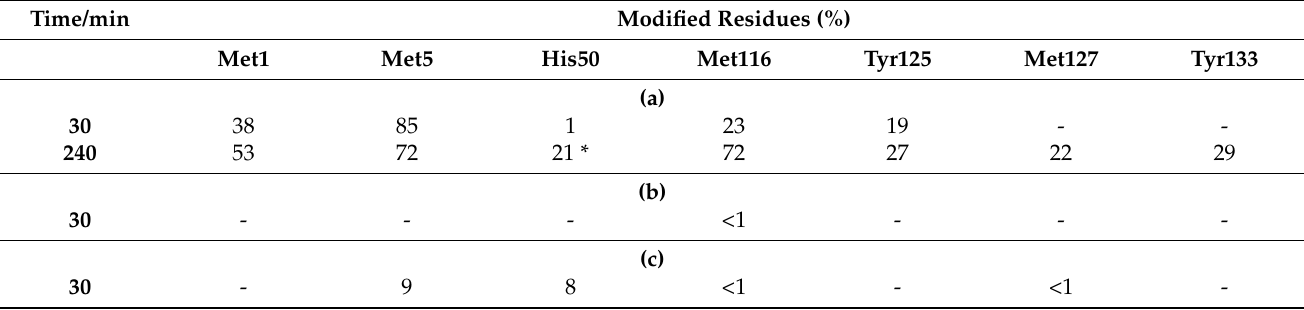
Table 2. Relative modification percentage of α Syn fragments in the presence of (a) 4MC and copper(II), (b) 4MC and copper(I) in micellar SDS, and (c) 4MC and copper(II) in SDS micelles. All modifications correspond to the O -insertion on the residues listed below, except for the star-marked (*) modification of His50 which represents an increment mass of +120/122